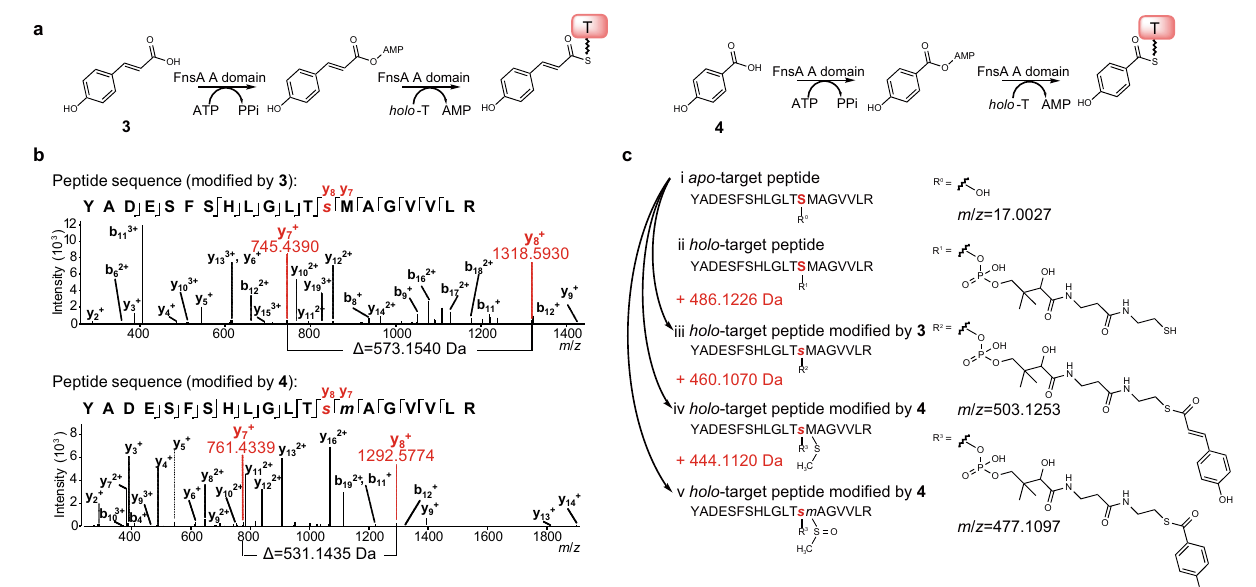
Fig. 4 | The FnsA A domain is responsible for the adenylation and thioester- i fi cation of 3 or 4. a Illustration of the reactions catalysed by the FnsA A domain when incubating with 3 or 4 . b LC-MS/MS fragmentations for the target peptide of FnsA A-T covalently attached to 3 or 4 after in vitro assays. c Structures and theo- reticalmassesshiftsofthemoleculesthatloaded 3 or 4 onSer607(markedinred). The labels “ b ” and “ y ” assign the N - and C -terminal fragment ions of the peptide